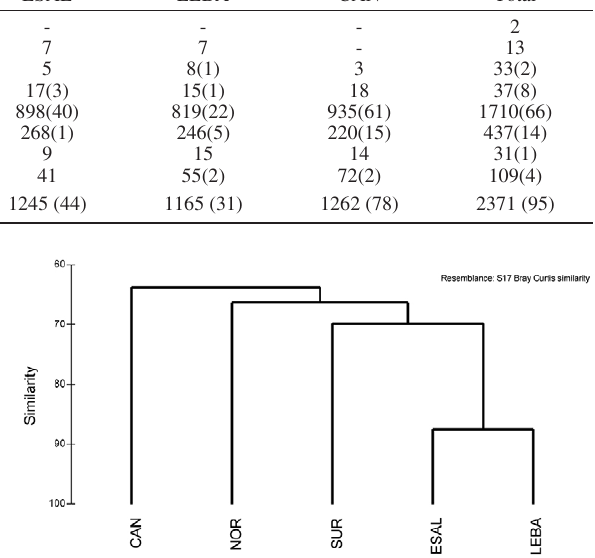
Table 5. – Number of benthic molluscan species recorded in Spanish jurisdictional waters, per class. First number, “P” records; number in brackets, “R” records. NOR SUR ESAL LEBA CAN Total Monoplacophora